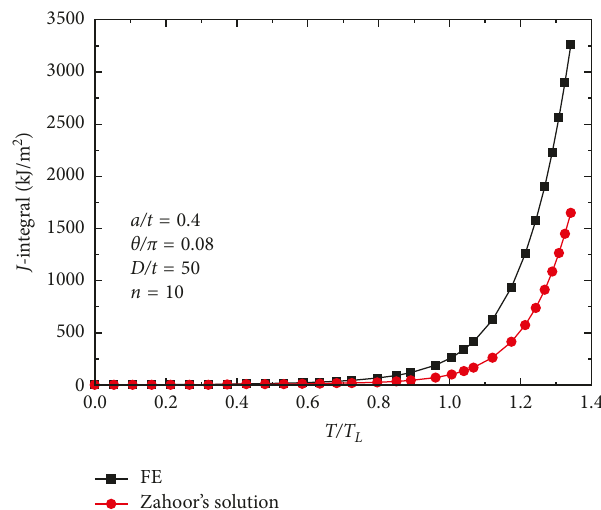
20, a / t 0.4, and θ / π 0.08. (cid:31) (cid:31) (cid:31)